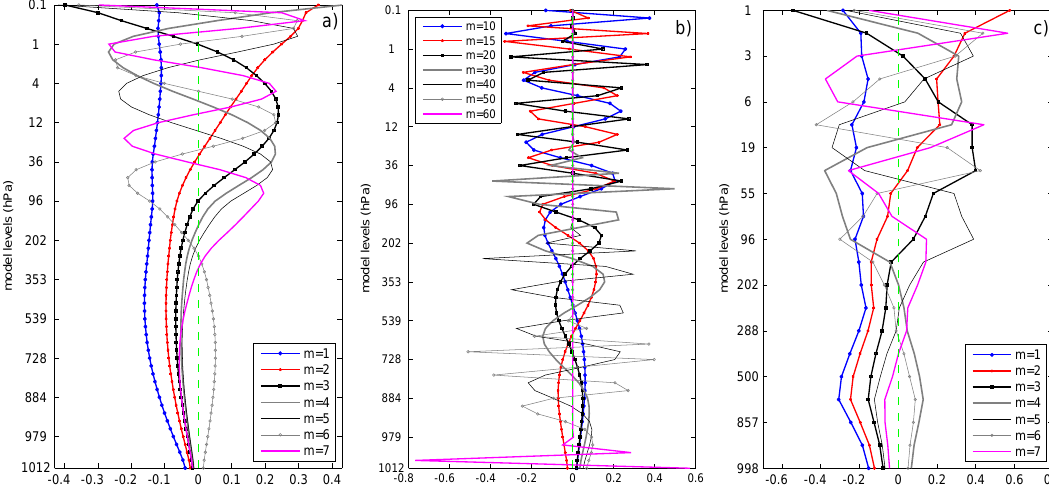
Figure 4. Vertical structure functions for (a) the first seven vertical modes and (b) modes 10, 15, 20, 30, 40 50 and 60, derived using the 60 levels of ERA Interim. (c) As (a) but for the case of 21 model levels closest to the standard 21 pressure levels.